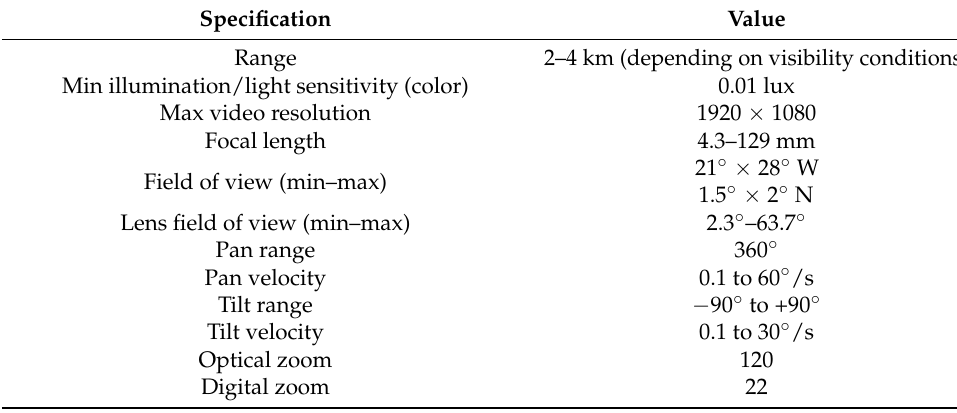
Table 10. Triton PT-Series HD camera specifications.